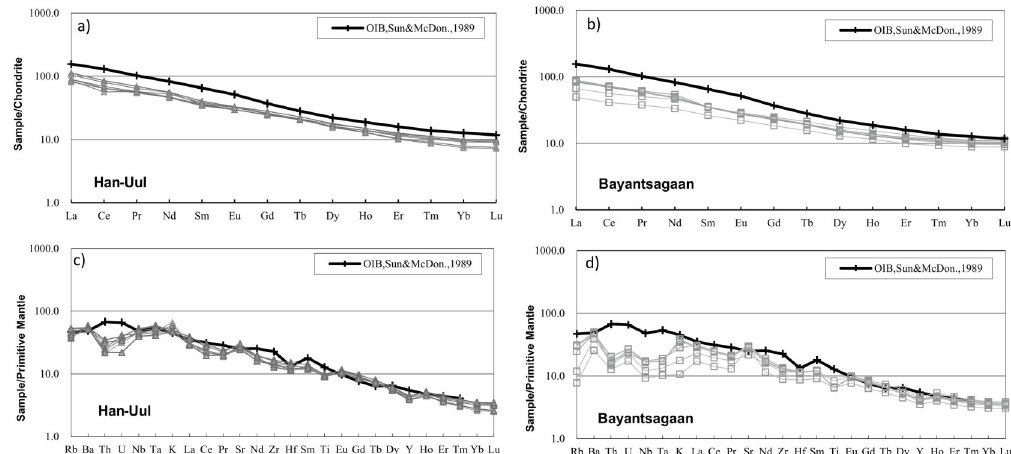
Fig. 6. Chondrite-normalized REE patterns and primitive mantle-normalized diagram for rocks of Early Cenozoic basalts from Han-Uul (a, c) late Cretaceous basalts from the Bayantsagaan (b, d) Normalizing values are from Sun and McDonough (1989) both chondrite and primitive mantle. For comparison, the ocean island basalt (OIB) (Sun and McDonough, 1989) is also